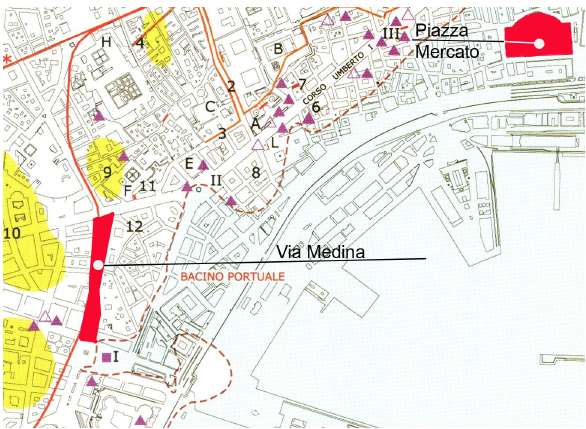
Figure 3: Naples in Greek-roman period according to reconstruction of archaeologists team led by D. Giampaola.